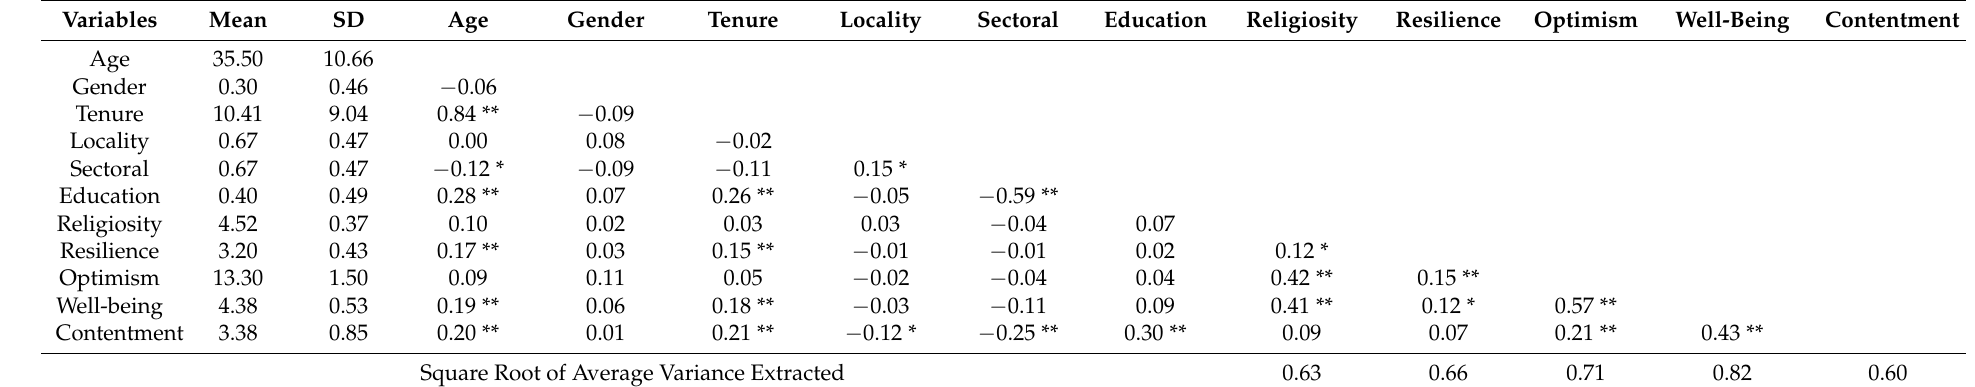
Table 2. Descriptive statistics, correlations and average variance of the study